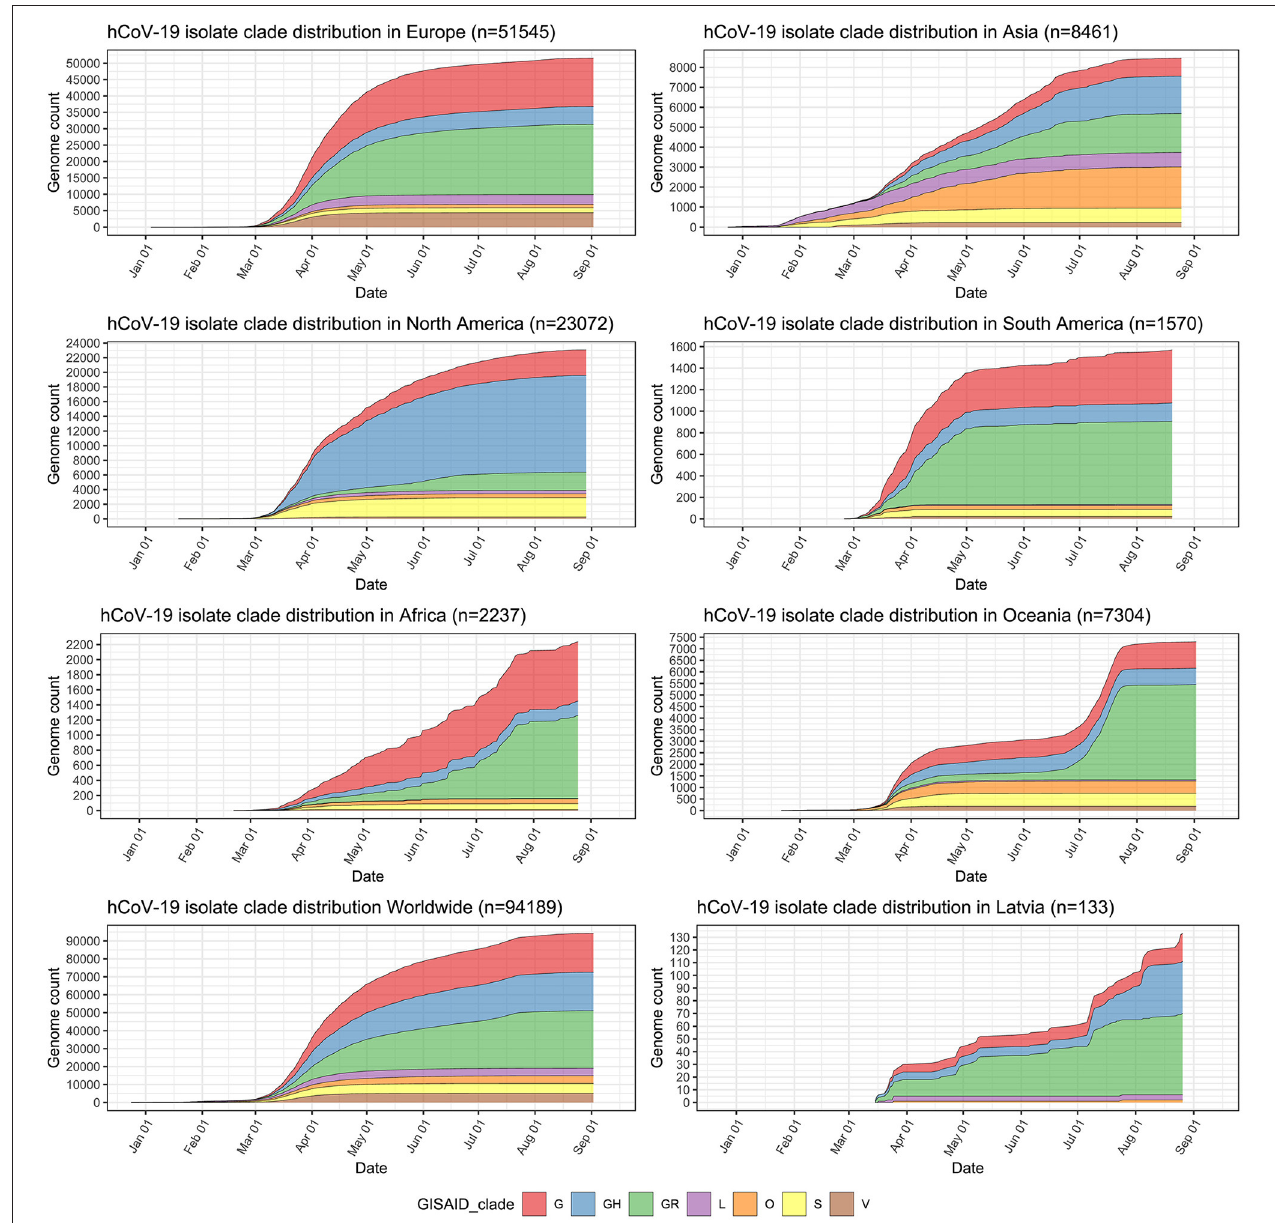
FIGURE 2 | Distribution of sequenced SARS-CoV-2 isolates by clades in major regions of the world, worldwide, and in Latvia. y -axis depicts cumulative complete SARS-CoV-2 genome count (with unambiguous collection date) from a particular region and has different scale within the subplots. x -axis is the same for all subplots and depicts sampling time-series from 24th of December, 2019 till 12th of September,